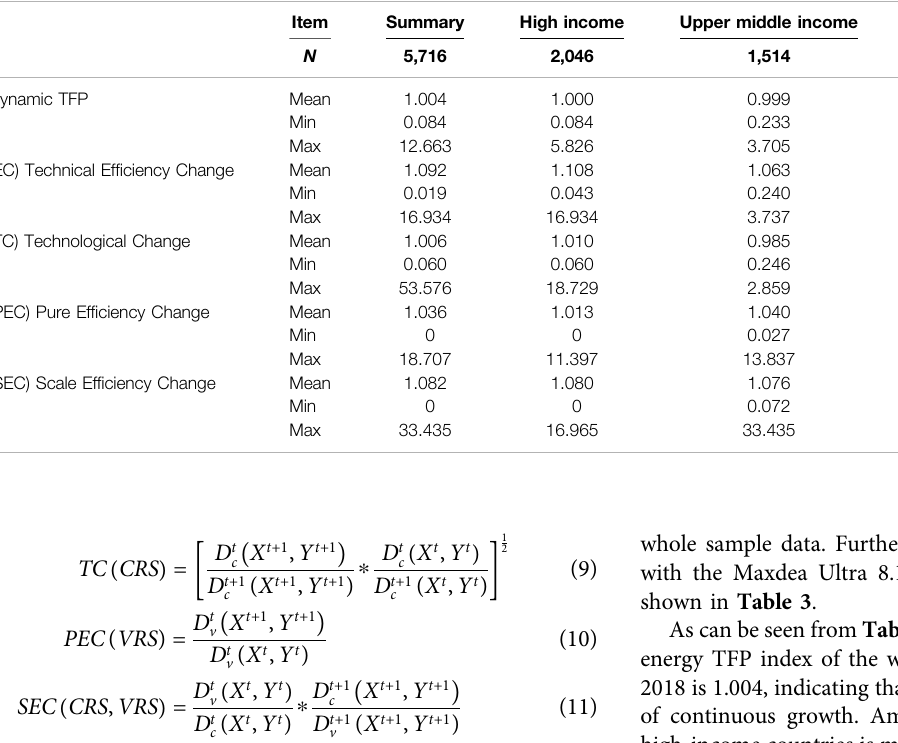
TABLE 2 | Descriptive statistics of dynamic energy